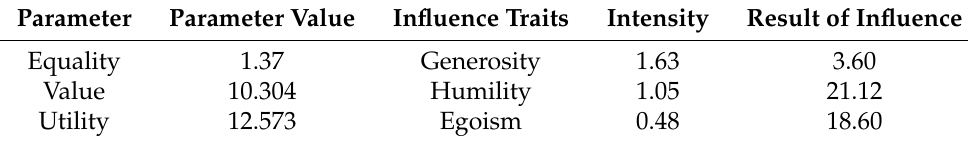
Table 11. Results of the influence of the satisfaction parameters with personality traits.